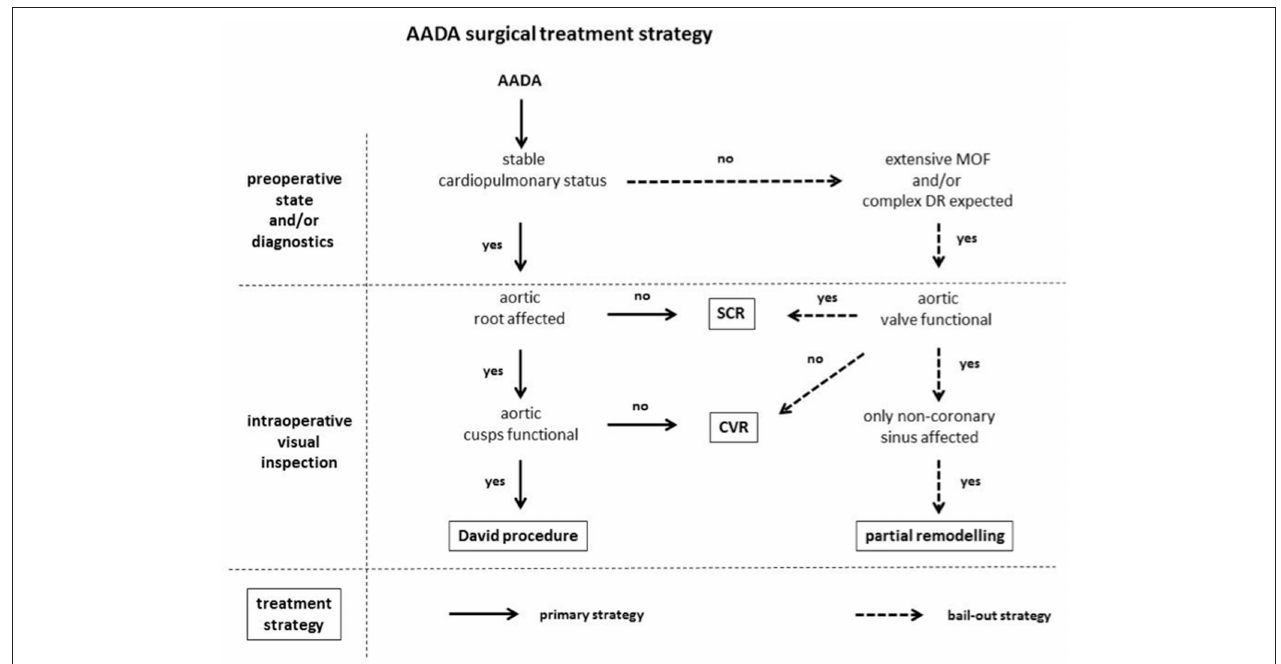
FIGURE 1 | AADA surgical treatment strategy. AADA, acute aortic dissection type A; MOF, multi-organ failure; DR, distal repair; SCR, supracoronary replacement; CVR, combined valve and aortic